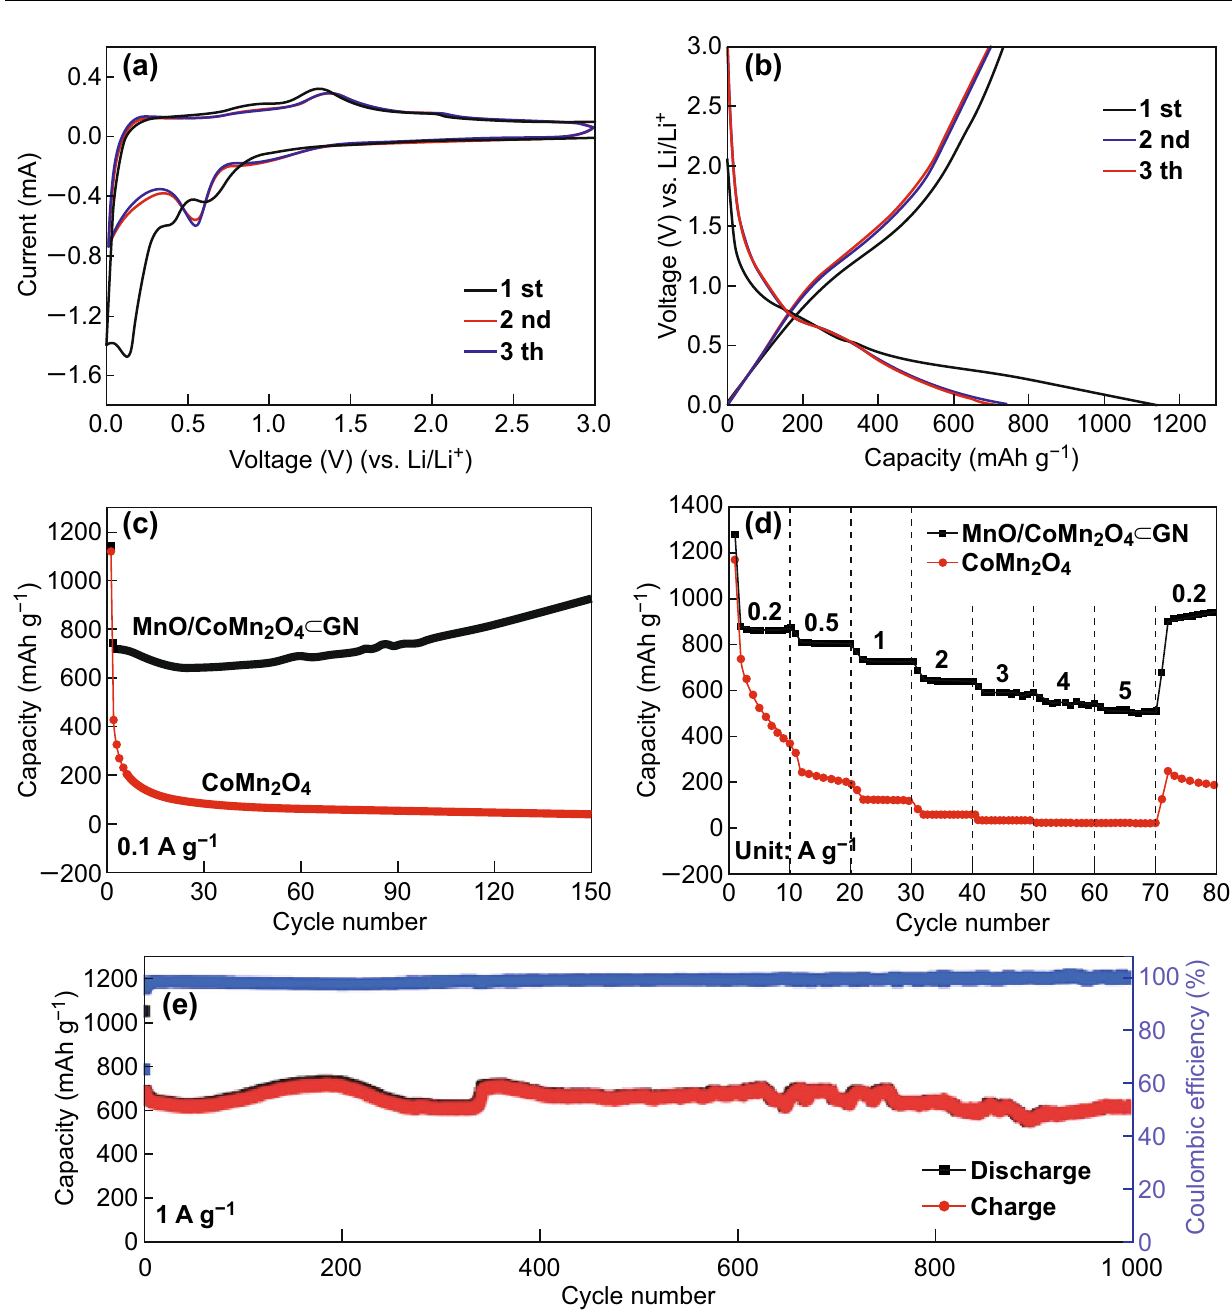
Fig. 5 a CV profile of MnO/CoMn 2 O 4 ⊂ GN at a scan rate of 0.1 mV s −1 in the voltage range of 0.01–3.0 V. b The charge and discharge profiles of MnO/CoMn 2 O 4 ⊂ GN. c Cycling performance and Coulombic efficiency of the CoMn 2 O 4 and MnO/CoMn 2 O 4 ⊂ GN electrodes at a current density of 0.1 A g −1 . d Rate performances of the CoMn 2 O 4 and MnO/CoMn 2 O 4 ⊂ GN electrodes at various current densities. e Cycling perfor- mance of the MnO/CoMn 2 O 4 ⊂ GN electrode at a current density of 1 A g